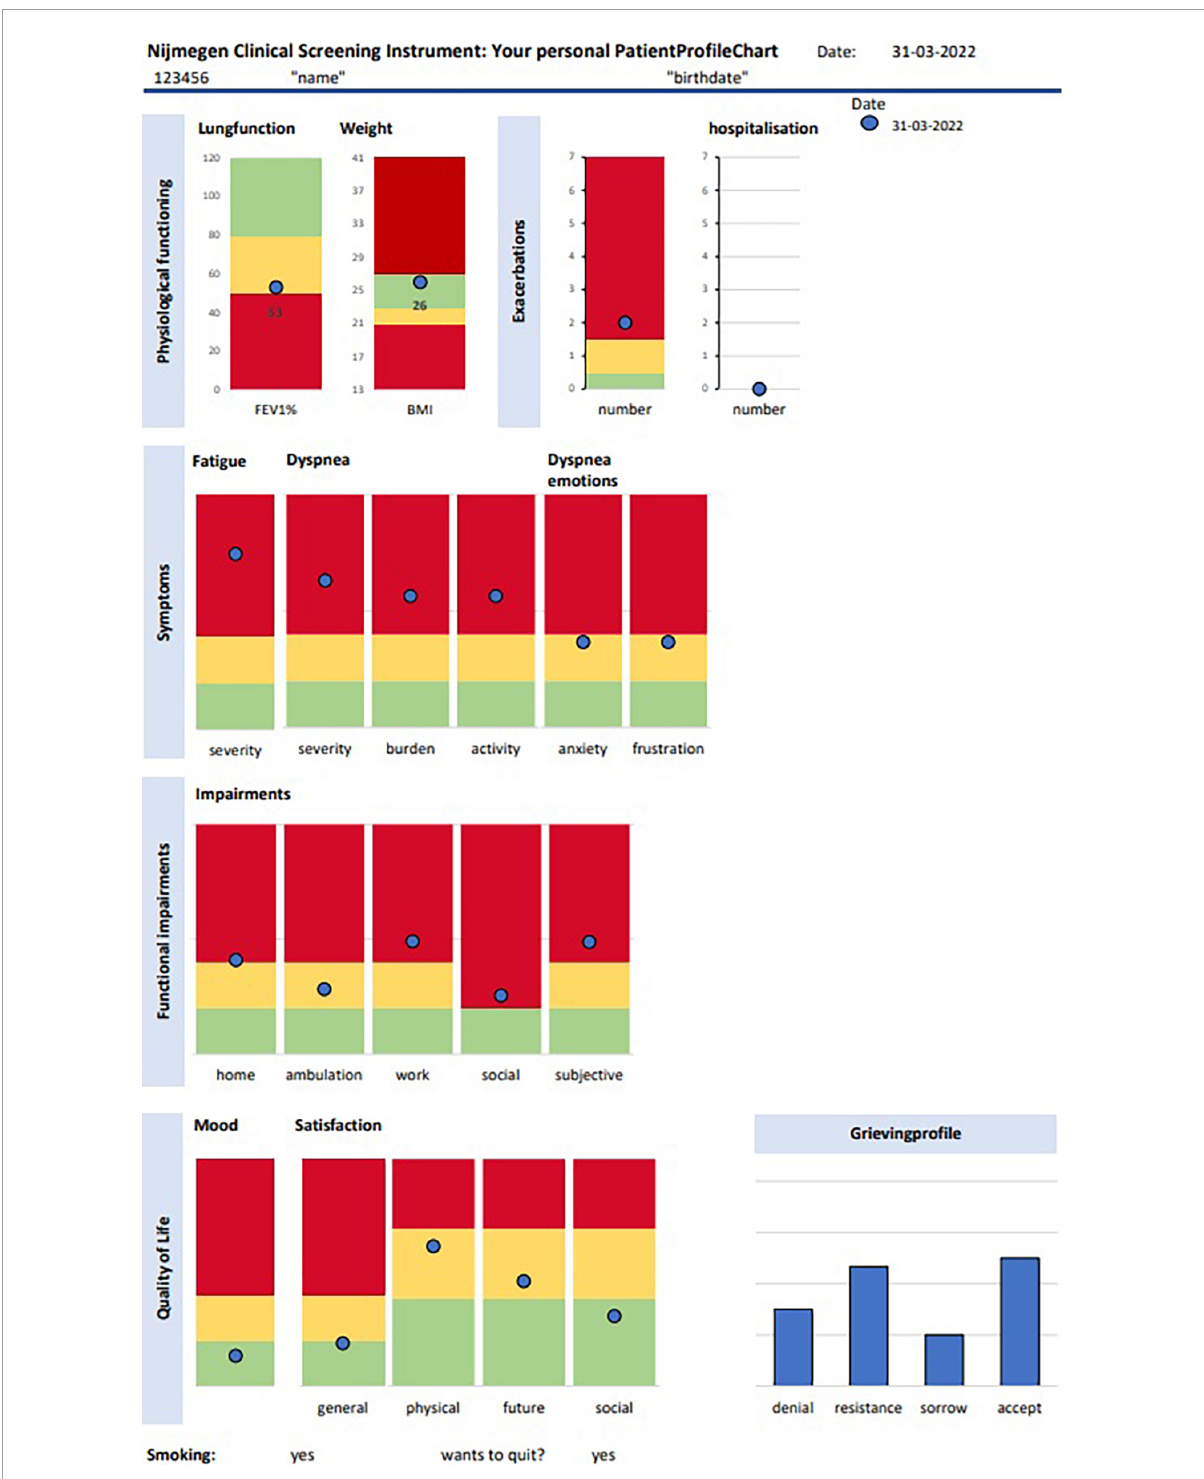
FIGURE1 Patient profile chart. The green score range indicates “normal functioning,” the yellow score range indicates “mild problems,” and the red score range indicates “severe problems.” Accep,